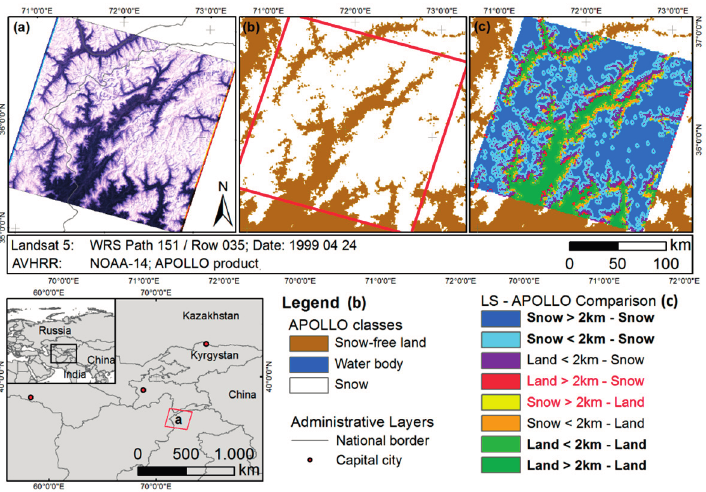
Figure 6. Accuracy assessment of Advanced Very High Resolution Radiometer (AVHRR) snow cover maps using Landsat.